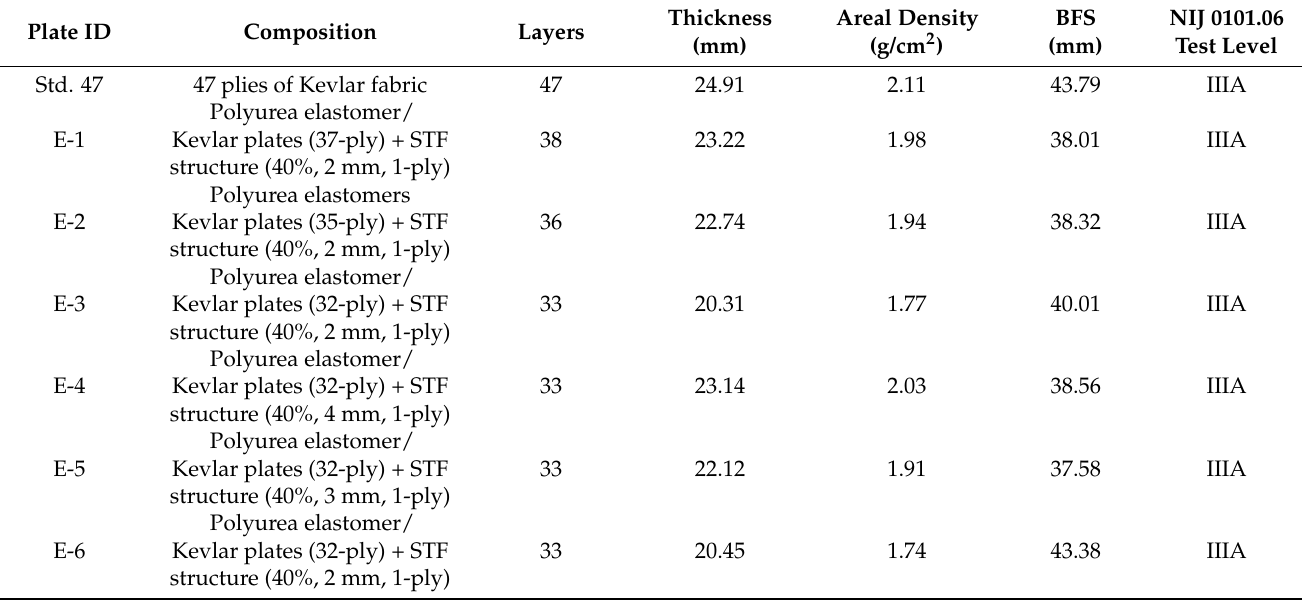
Table 4. The influence of boundary effects (target area size, surface density and thickness parameters). Plate